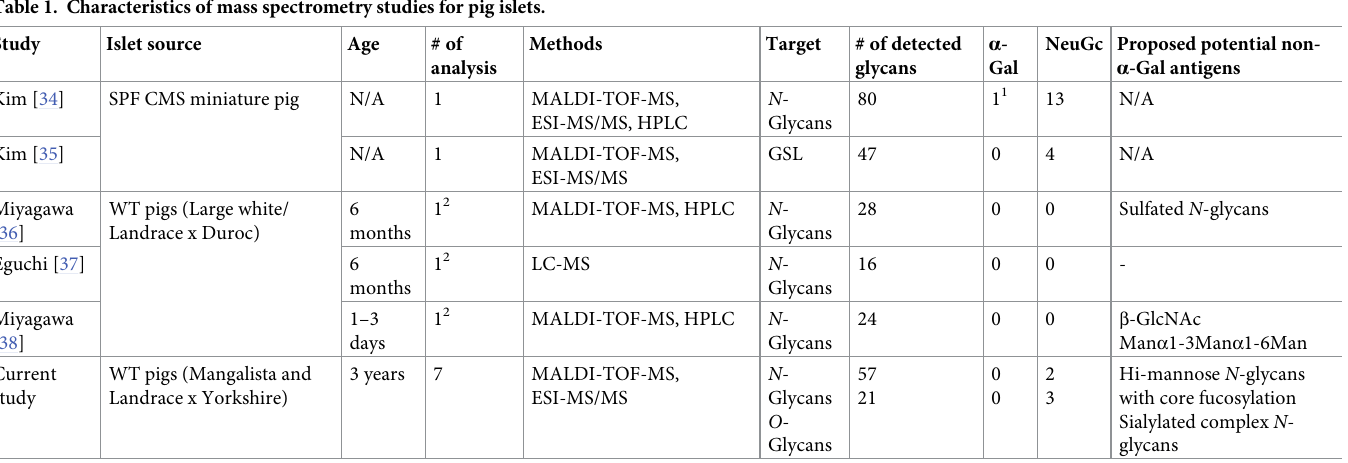
Fig 7. Summary of O -linked glycans detected from adult porcine and human islets by MALDI-TOF-MS and ESI-MS/MS. 1 All masses (mass +Na) are permethylated and single-charged values measured by MALDI-TOF-MS. The structure assignment were based on common biosynthetic pathway and ESI-MS/MS fragmentation by HCD. 2 % O -glycans were calculated from the area units of detected O -glycans.